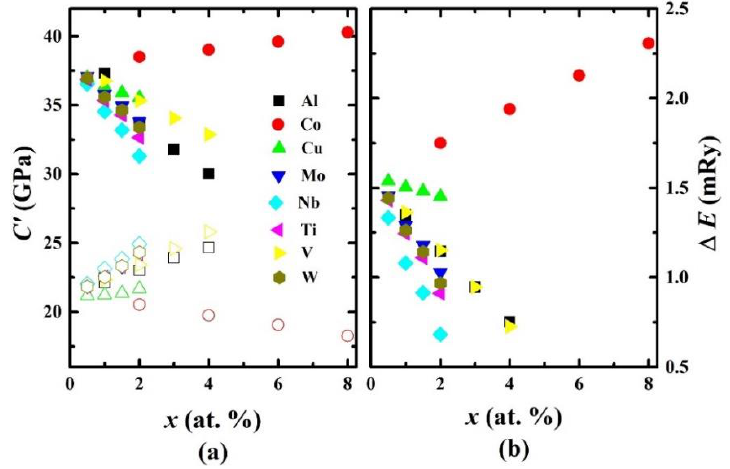
Figure 4. ( a ) Calculated fcc (solid symbols) and bcc (open symbols) tetragonal shear constant C′ values and ( b ) the calculated total energy difference Δ E (∆ E = E bcc − E fcc ) between the bcc and fcc structures of paramagnetic Fe 0.6 − x Cr 0.2 Ni 0.2 M x (M = Al, Co, Cu, Mo, Nb, Ti, V, and W; 0 ≤ x ≤ 0.08) quaternary alloys as a function of atomic concentration x .